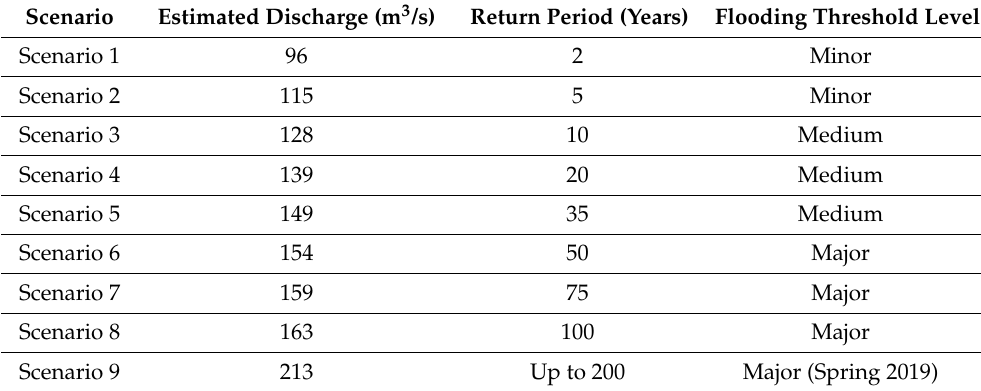
Table 3. The nine scenarios for the Petite-Nation River watershed with their corresponding discharge expressed in m 3 /s and return period in years.